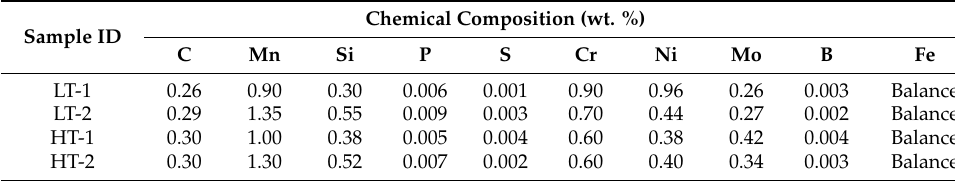
Table 4. Chemical composition of ballistic steel samples.